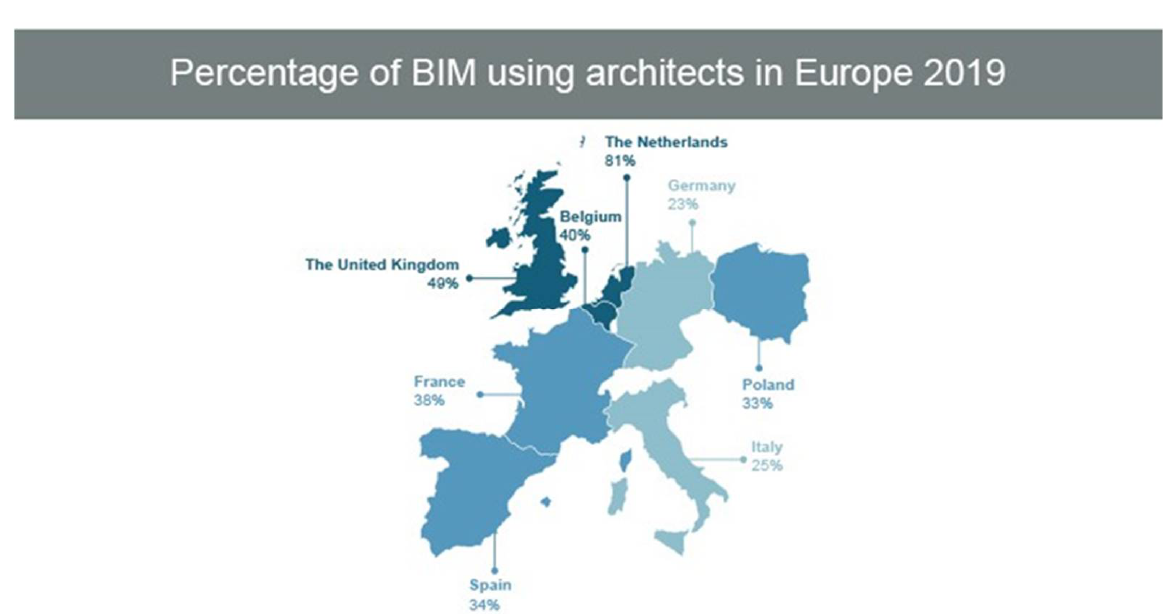
Figure 6. European Architectural Barometer Q4 2019, USP Marketing Consultancy.